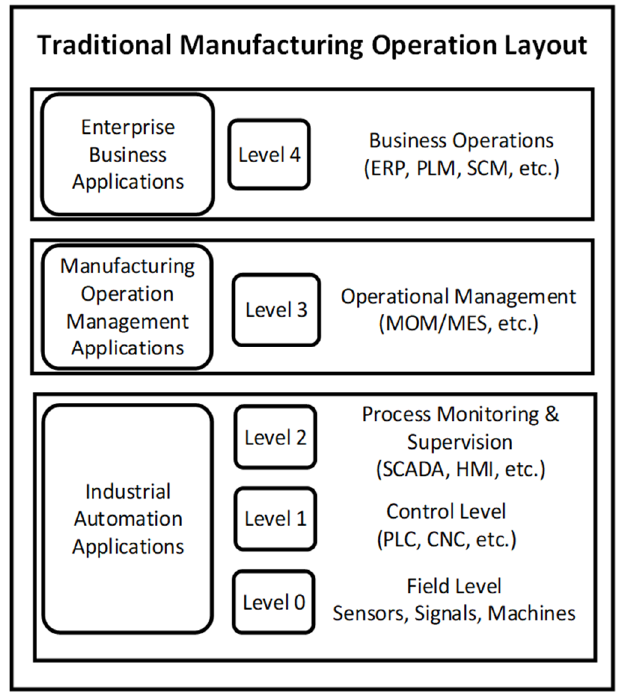
Figure 8. Gear 3—integration stage and Industry 4.0 technology jigsaw. (Primary technologies represented in color, secondary technologies represented in grey).